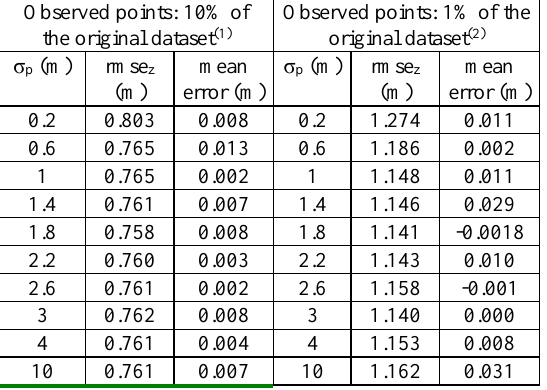
interpolation method (1 m grid spacing DSM and σ p = 1